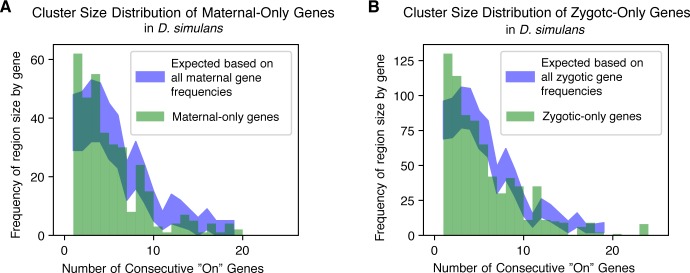
Stage-specific genes are more likely to be different from their chromatin neighborhood.D. simulans was chosen as a representative species. (A) Co-expressed cluster size distribution of maternal-only genes (green bars) compared with the expected frequencies based on the overall cluster size frequencies observed at stage two (blue region). The expected frequencies are based on the distribution in Fig 5A multiplied by a scale factor equal to the proportion of maternally deposited genes that are maternal-only, with the shaded region representing a 95% confidence interval. (B) Co-expressed cluster size distribution for zygotic-only genes (green bars) compared with the expected frequencies based on the overall cluster size frequencies observed at stage 5 (blue region) in a manner similar to Fig 6A. the shaded region represents a 95% confidence interval. For both stages, stage-specific genes are more likely to be the single gene (or one of a small number of genes) that are expressed where their neighboring genes are not, representing small numbers of “on” genes in an “off” chromatin environment.